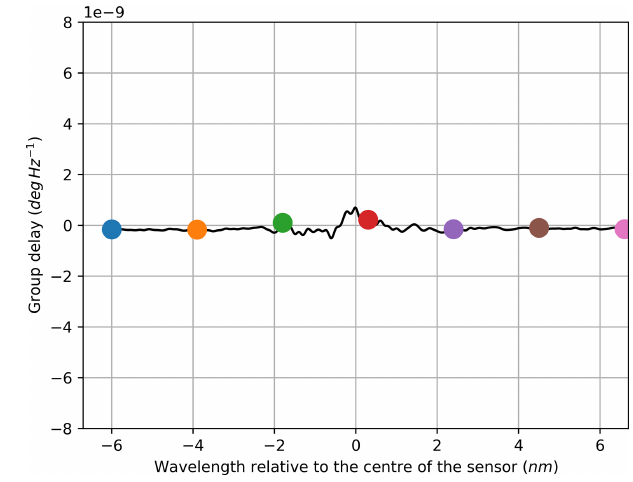
Figure 15. Group delay derived from the electrical phase of a cFBG in reflection